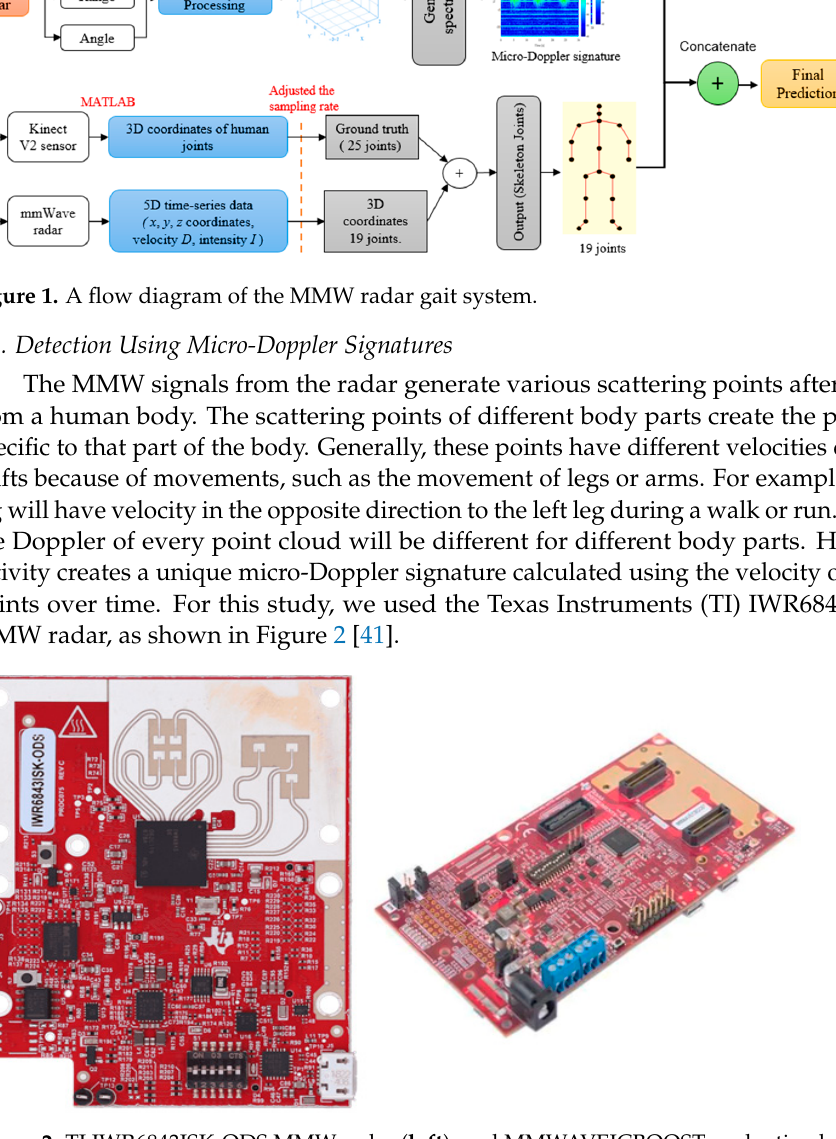
Figure 2. TI IWR6843ISK-ODS MMW radar ( left ), and MMWAVEICBOOST evaluation board ( right